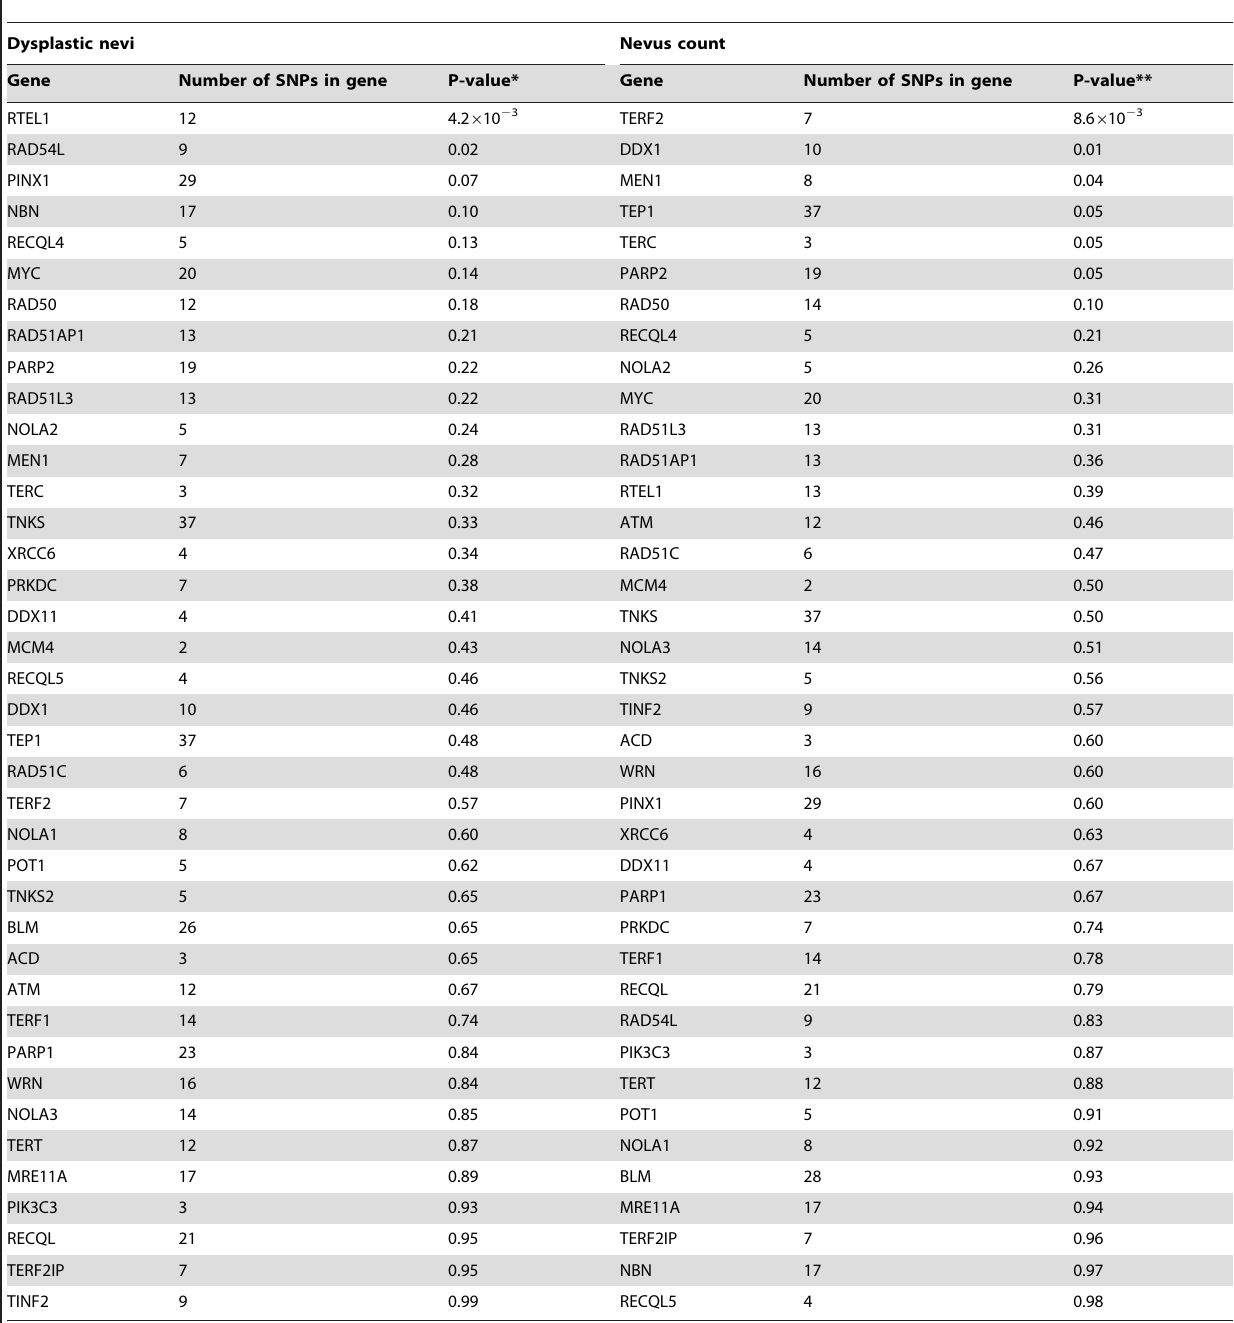
Table 3. Gene-based association analysis and risk of dysplastic nevi and number of nevi in unaffected subjects.